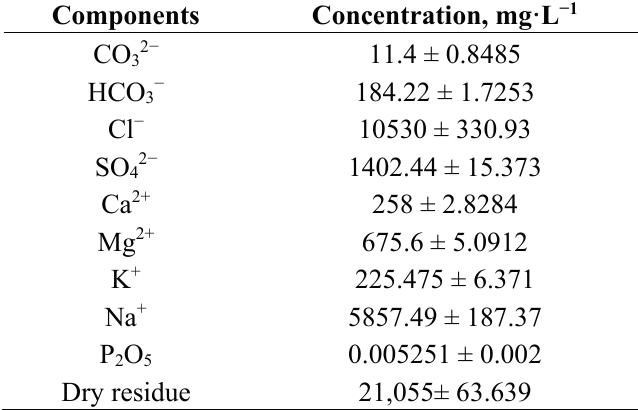
Table 2. The chemical composition of marine water from Black Sea that was used in the experiments to study phosphorus deprivation in TA-P/SW